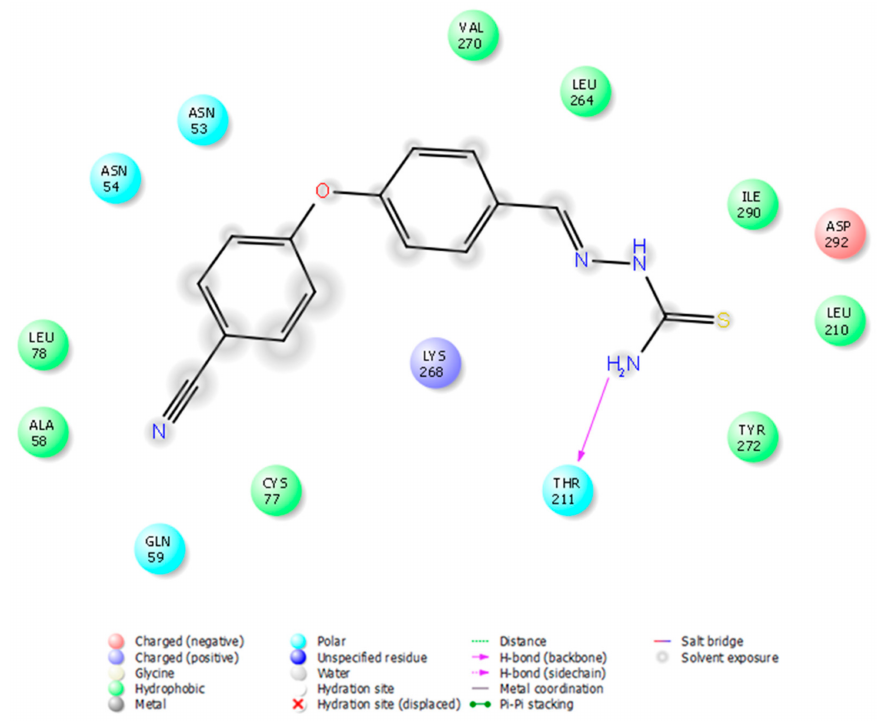
Figure 4. Docking interactions of compound A with proper residues in the active site of